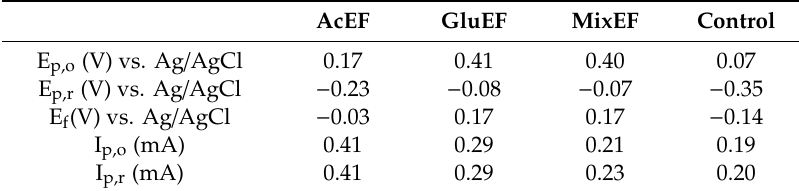
Figure 3. Cyclic voltammogram for the bulk solution depending on the substrate type in the anaerobic reactor exposed to an electric field (solid line: oxidation, dashed line: reduction). Table 2. Redox peaks for the bulk solution depending on the substrate type in the anaerobic reactor exposed to an electric field.